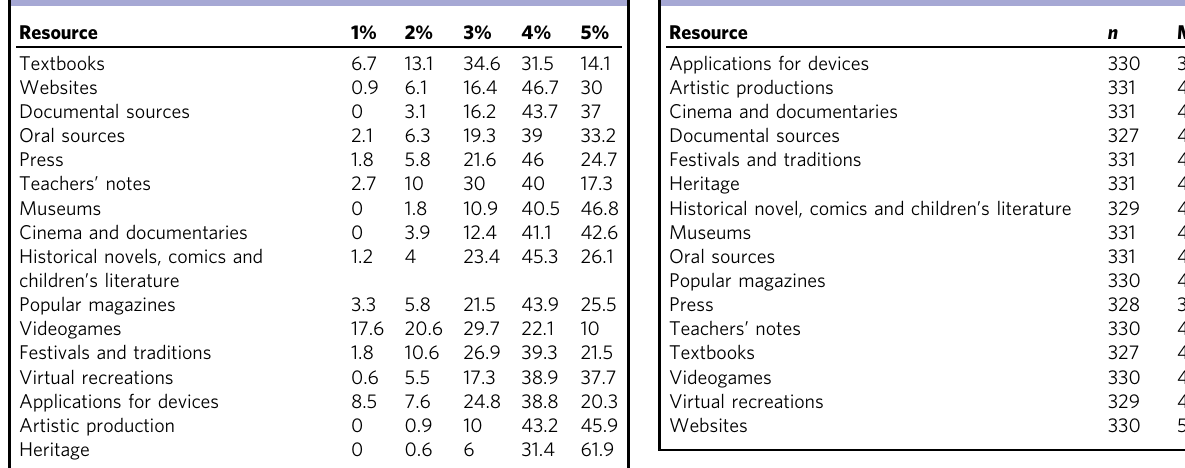
Table 2 Frequency of responses from surveyed teachers.